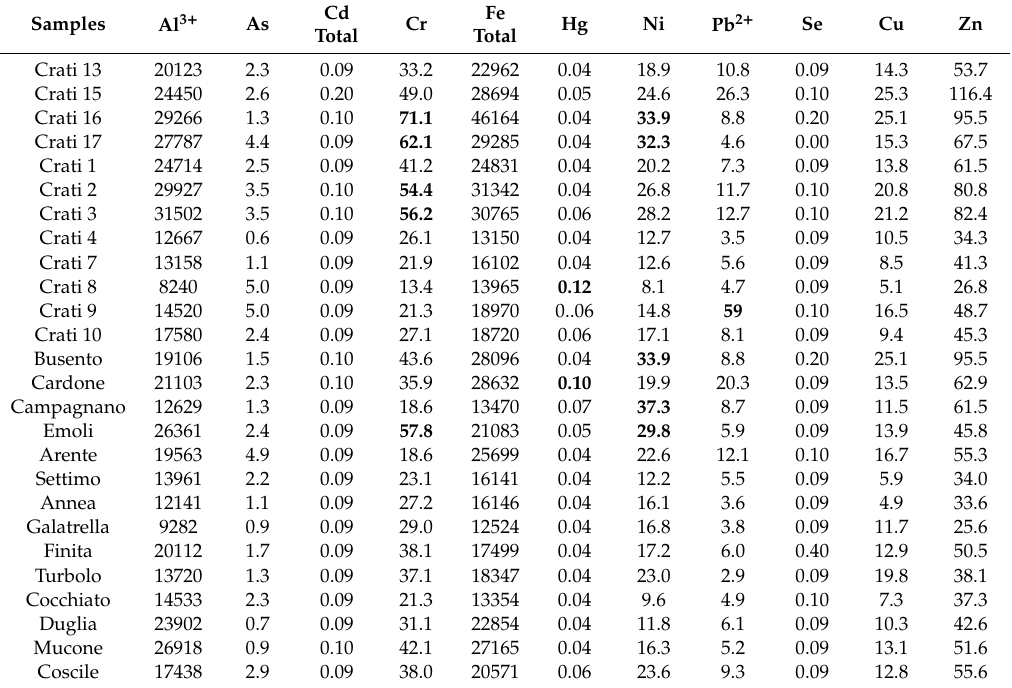
Table 3. Data set including the analytical parameters calculated for the sediment samples. The concentration values are expressed as mg / mL. Measured values higher than those allowed by the reference standard are shown in